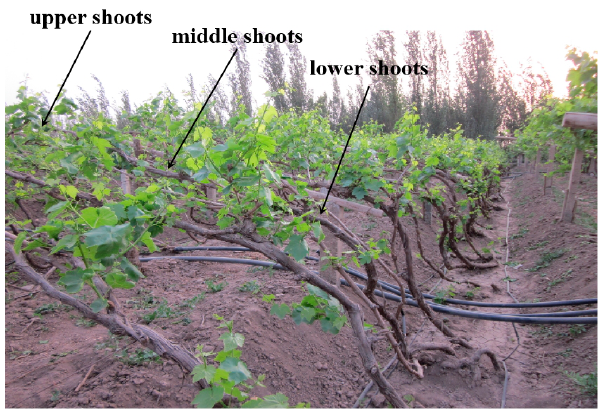
Figure 1. Cultivation pattern of the grapevines in the field. The principal growth stage is shoot development.